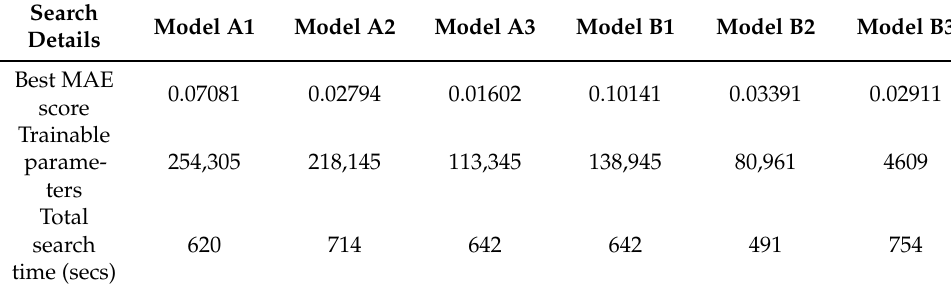
Table 1. Trainable parameter search